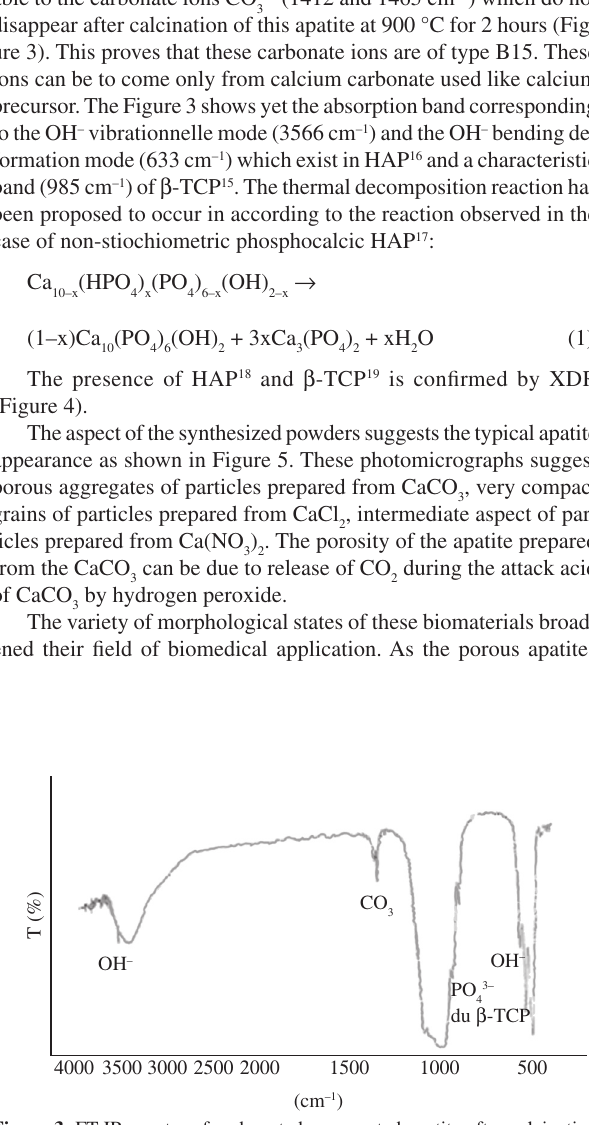
Figure 3. FT-IR spectra of carbonated oxygenated apatite after calcination at 900 °C for 2 hours.